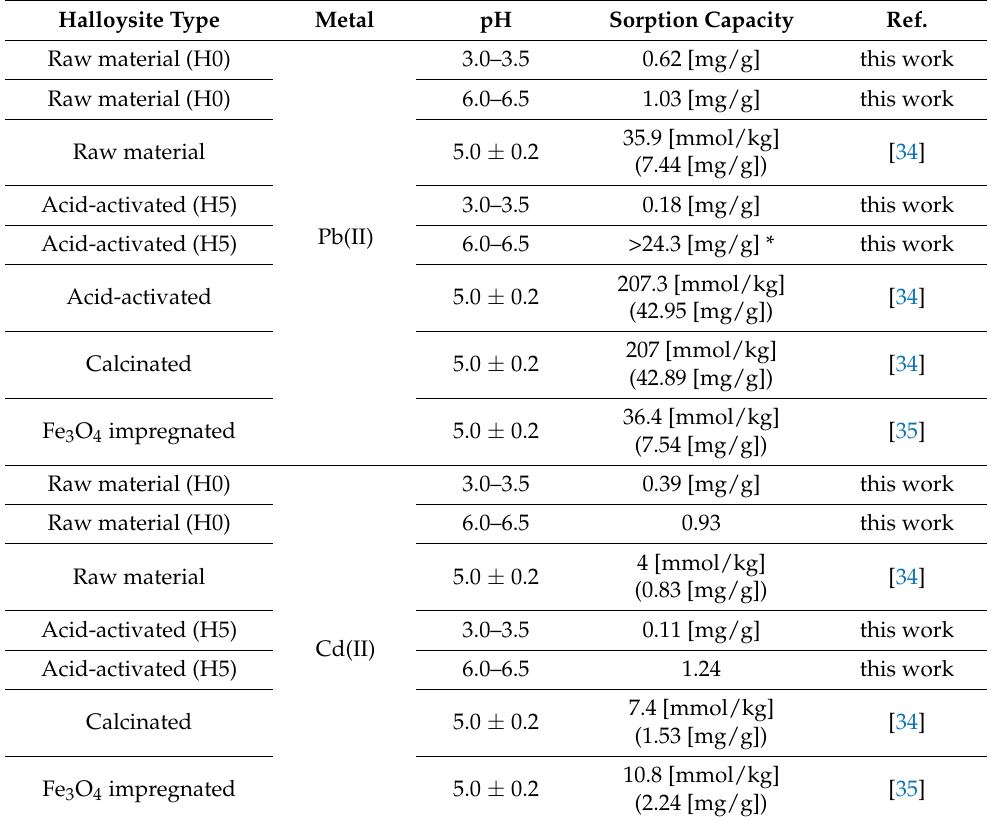
Table 6. Sorption capacity calculated for the raw (H0) and sulphuric acid-treated (H5) sample of halloysite, compared with the reference values [34,35].